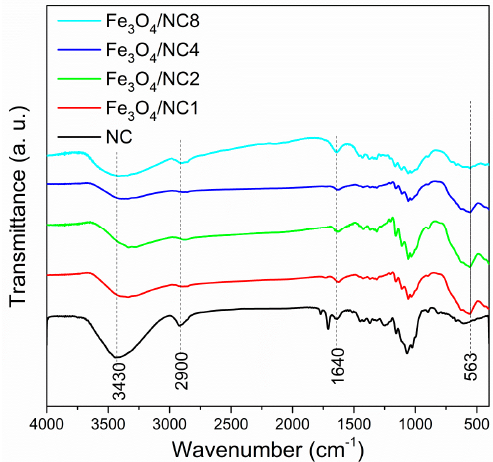
Figure 2. FTIR spectra of of Fe 3 O 4 /NC composites.